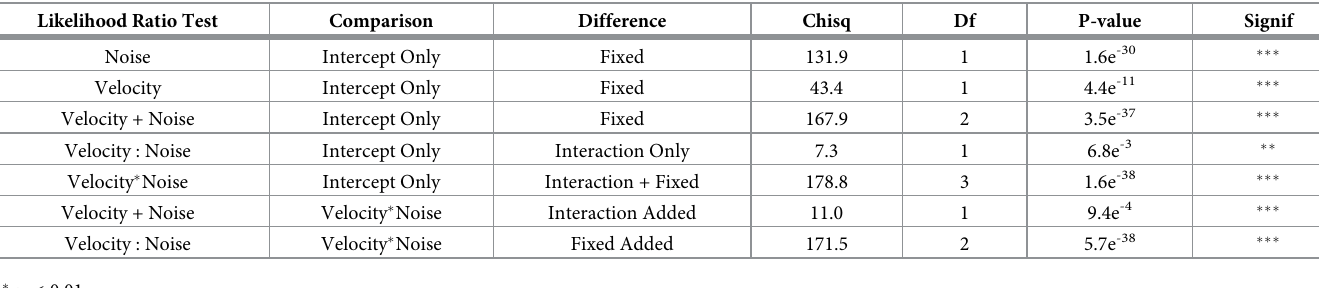
Table 2. Likelihood ratio test results for the linear mixed effects